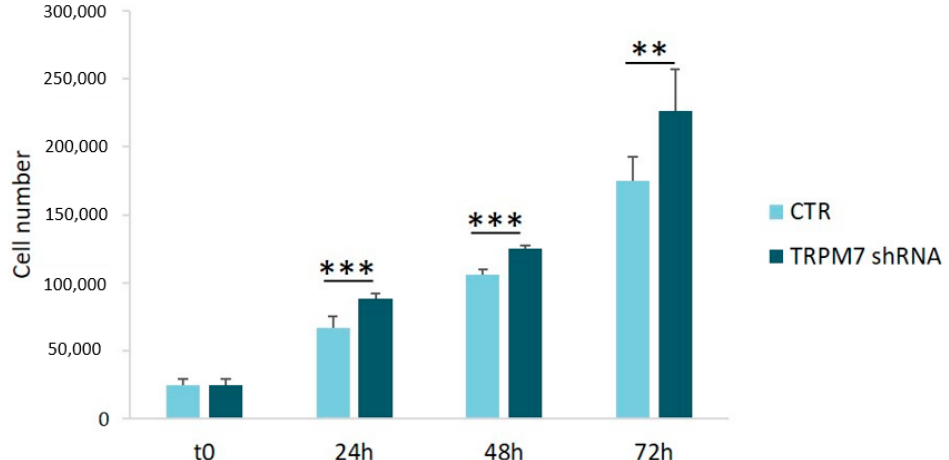
Figure 5. Cell proliferation in TRPM7-silencing HUVEC. TRPM7-silencing/-expressing HUVEC (TRPM7 shRNA and CTR, respectively) were counted with an automated cell counter after 24, 48 and 72 h of treatment with doxycycline. Cell numbers were expressed as the mean ± SD. ** p ≤ 0.01, *** p ≤ 0.001.